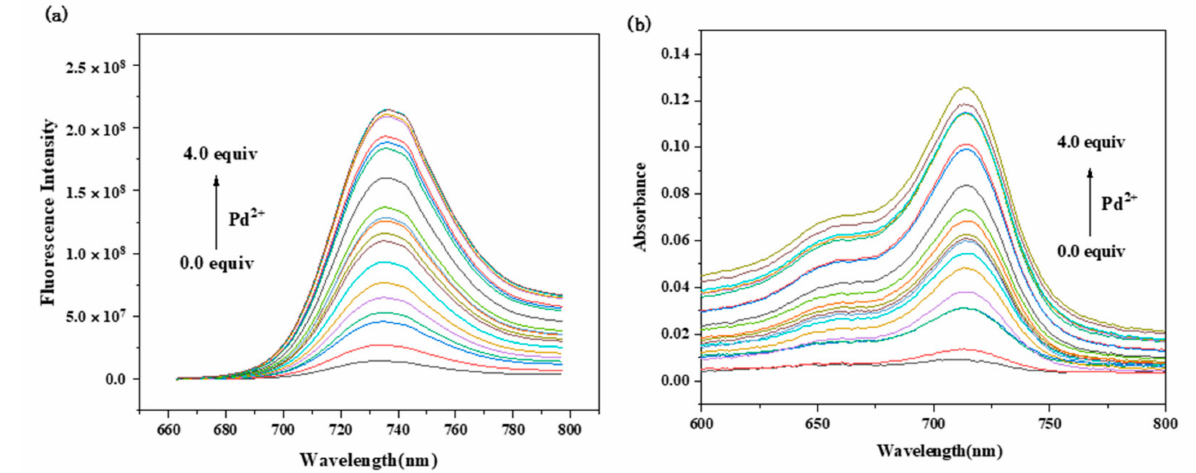
Figure 2. ( a ) Fluorescence and ( b ) UV-Vis spectra of probe RCya titrated with Pd 2+ at the excitation wavelength of 635 nm (RCya: 10 µ mol L − 1 , Pd 2+ : 0.0–4.0 equiv. to